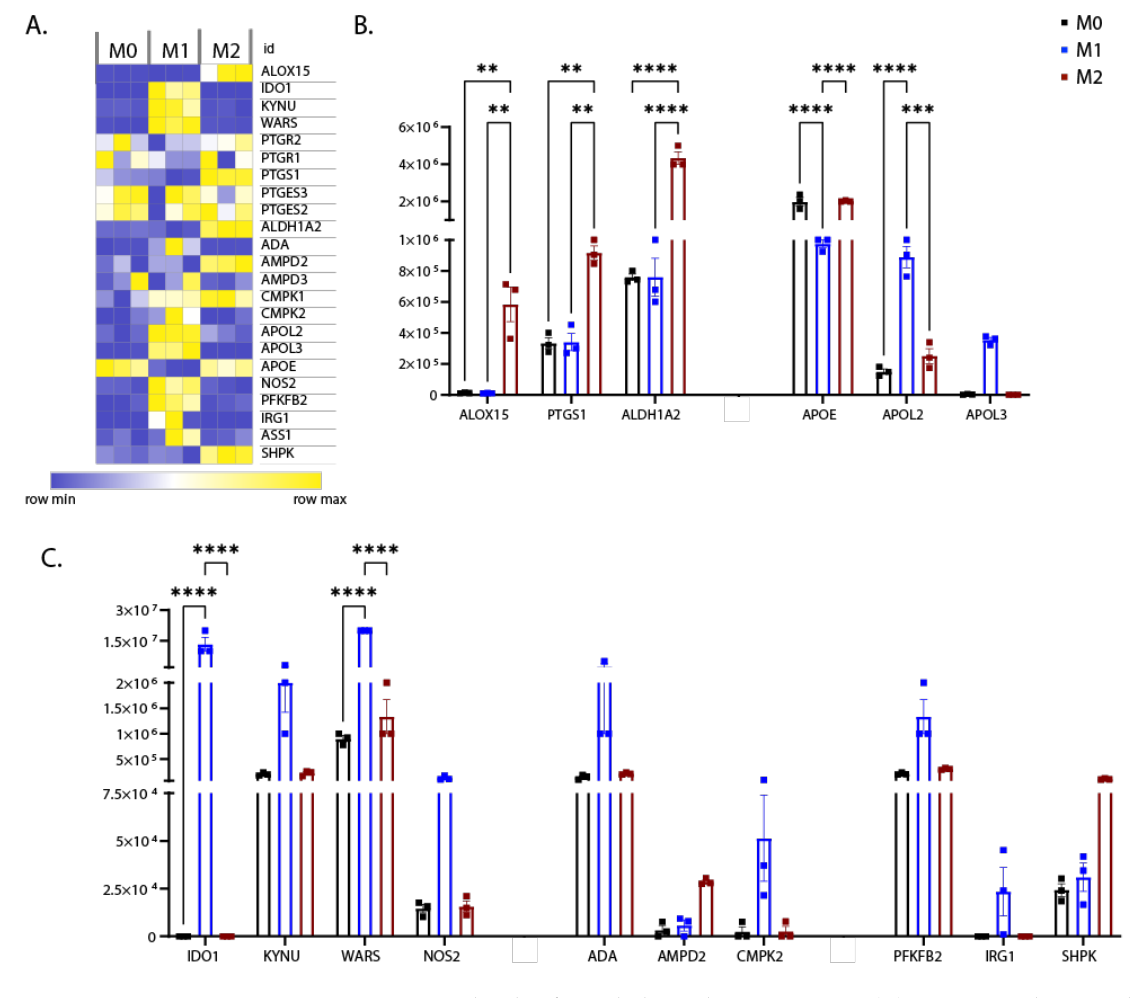
Figure 8. Expression levels of metabolic pathway proteins. ( A ) Heat map showing differential expression of proteins involved in metabolic pathways across biological replicates of differentially polarised iPSDM. ( B and C ) Graph shows the estimated copy numbers per cell using the proteomic ruler approach. p values: **0.01, *** 0.001, **** 0.0001. Apolipoproteins are involved in the regulation of cholesterol levels and also function as effectors of the immune response to pathogens [49]. In the M1 proteome, we found